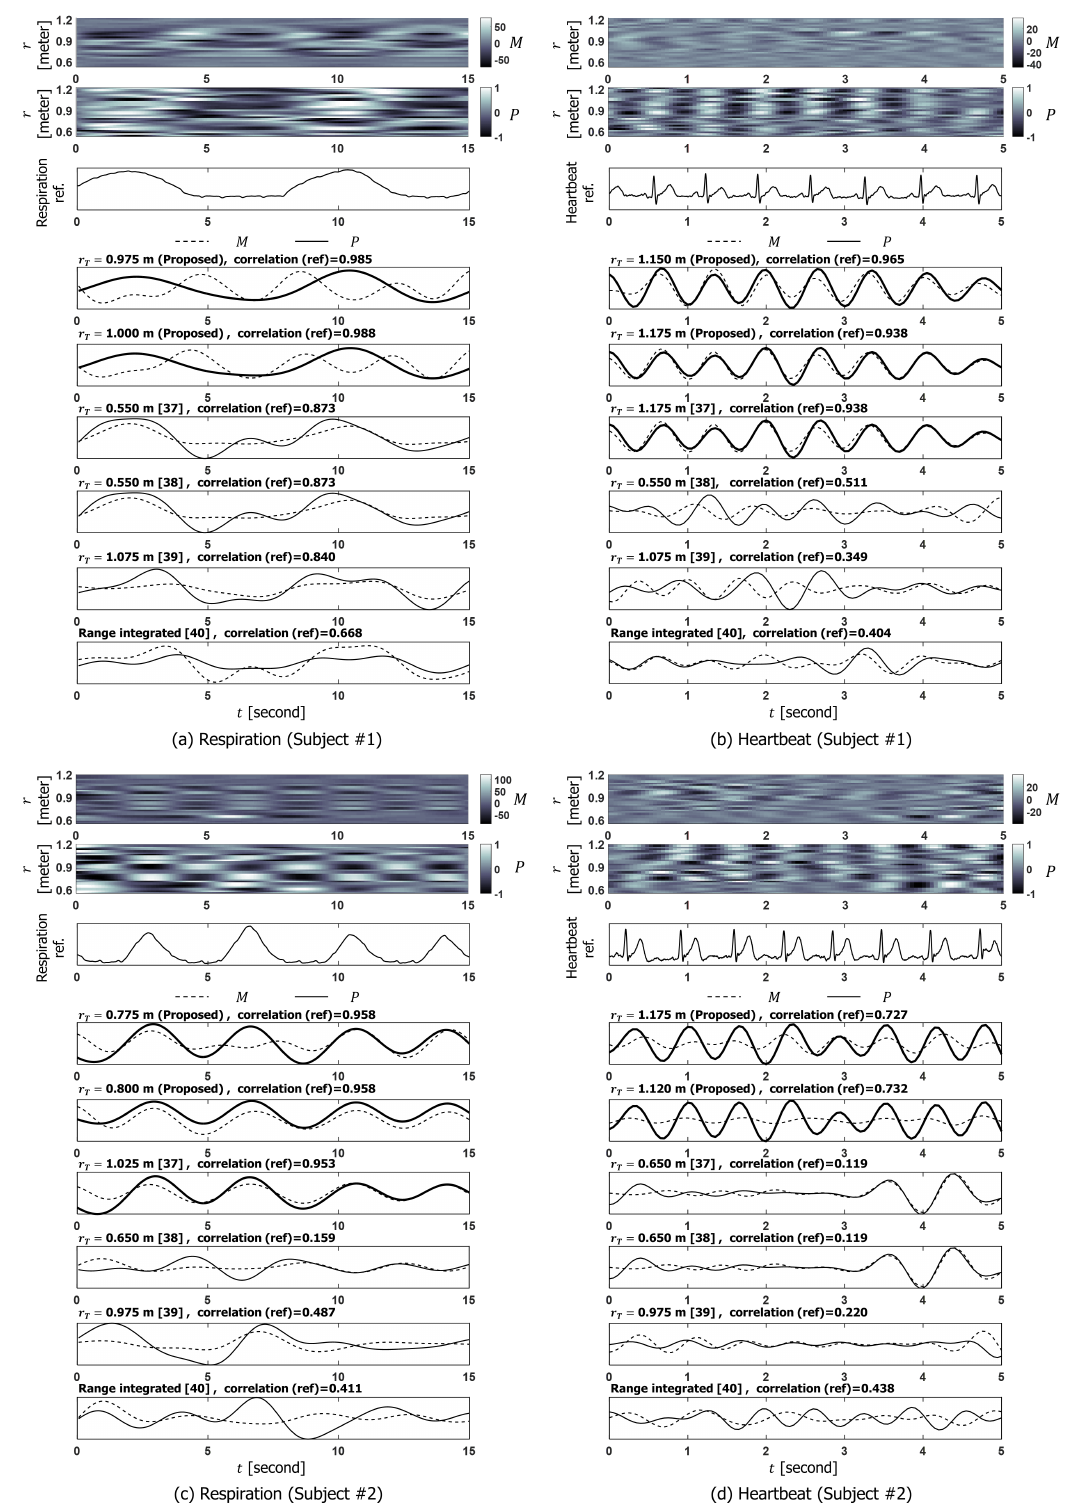
Figure 5. Extracted vital signs. ( a , b ) Extracted respiration and heartbeat signals for subject#1, and ( c , d ) extracted respiration and heartbeat signals for